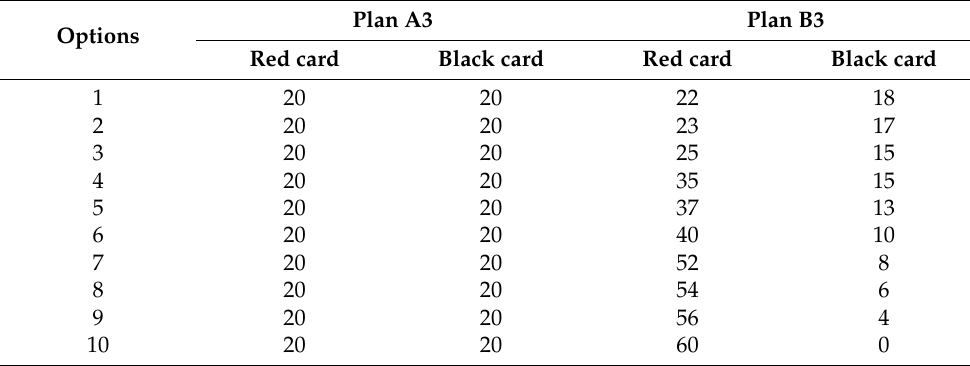
Table A3. Experimental protocol. Plan A3 Plan B3 Options Red card Black